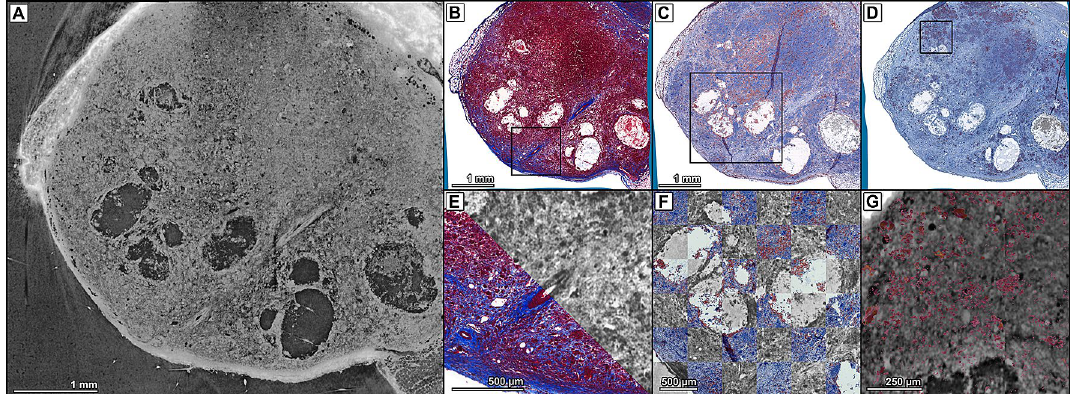
Figure 4. Matching of SRµCT data with different histological staining obtained from BaNPs injected mouse breast cancer tissues. ( A ) SRµCT virtual histology at the plane corresponding to the MTS histology shown in ( B ). ( B ) MTS histology. ( C ) Anti-CD68 immunohistochemistry. ( D ) Anti-TAg immunohistochemistry. ( E ) Comparison of MTS staining with the corresponding CT slice of a magnified region as indicated by the black box in ( B ). Grey values are inverted. ( F ) Checkerboard comparison of anti-CD68-IHC staining with the corresponding CT slice of a magnified region as indicated by the black box in ( C ). Grey values are inverted. ( G ) Overlay of segmented T-Ag positive tumour cells with the corresponding CT slice of a magnified region as indicated by the black box in ( D